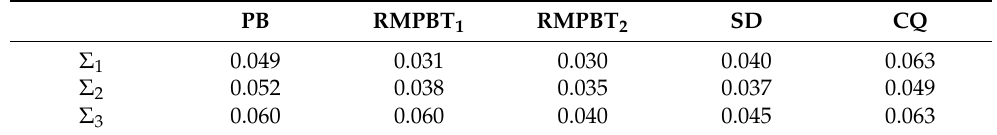
Table 1. Empirical sizes based on 1000 replications with α = 0.05, n 1 = n 2 = 70 and p = 1000. RMPBT is the approach of [12], SD is the approach of [4] and CQ is the approach of [7].